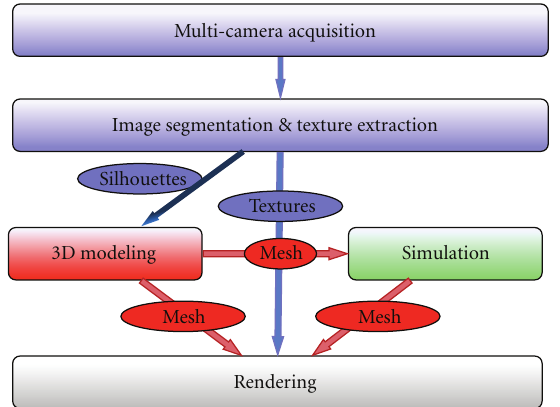
Figure 6: Application architecture coupling a multicamera acquisi- tion space and a virtual physical